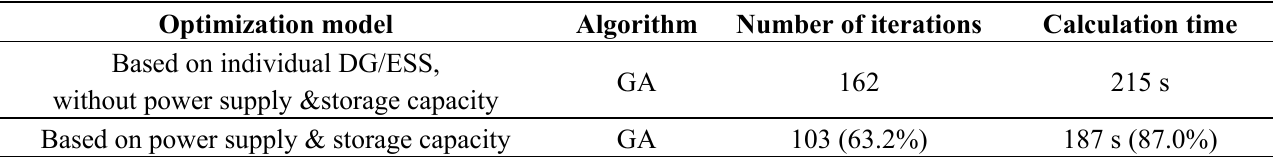
Table 3. Computation cost comparison of the optimization in different